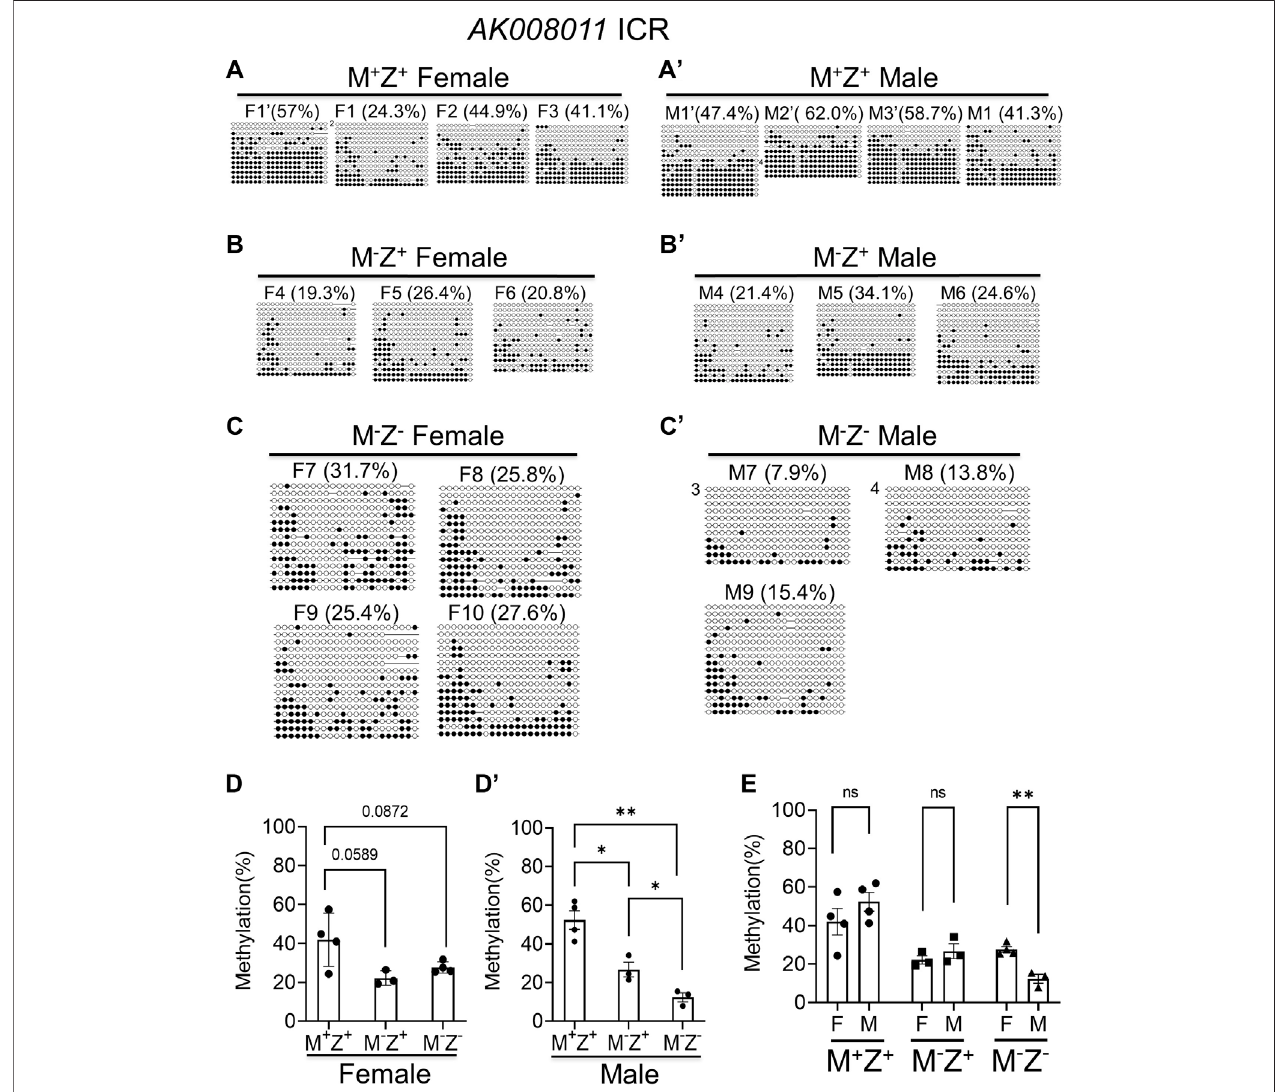
FIGURE 4 | DNA methylation at the AK008011 ICR was more signi fi cantly reduced in the male M - Z - embryos compared with the female ones based on bacterial colony bisul fi te sequencing analysis. Genomic DNA samples were isolated from at least three M + Z + , M − Z + , or M − Z - E13.5 embryos of each gender that had been used for RNA-seq analysesinthisstudytoo.Theyweresubjectedtobisul fi temutagenesisfollowedbybacterialcolonysequencingofthe605-bpbisul fi tePCRproductofthe AK008011 ICRregion. Theunconvertedcytosine (C) residueswereusedtodeterminetheuniqueclonesforthebisul fi tecolonysequencing.Eachrowrepresentsauniqueclone,withthe fi lledblack circlesformethylatedCpGsitesandun fi lledwhitecirclesforunmethylatedCpGsites.Thenumberinfrontofauniquecloneshowsthenumberofsequencednon-uniqueclones containing the same sequence that cannot be distinguished by unconverted (C) residues. The percentage of DNA methylation in (A,C ’ ) was calculated based on the number of methylated CpG sites divided by the total number of CpG sites for the sequenced unique clones of the bisul fi te PCR product. Two-tailed Student ’ s t test was used for statistical analysisofDNAmethylationleveldifferencesbetweentwodifferentgenotypesofthesamegender (D,D ’ ) orwithinthesamegenotypebetweenmalesandfemales (E) .Statistical signi fi cance:*, p < 0.05;**, p < 0.01; ns,notstatisticallysigni fi cant. (A ’ ) Four M + Z + femaleembryos(F1 ’ andF1 – F3). (A ’ ) Four M + Z + maleembryos(M1 ’– M3 ’ and M1). (B) Three M − Z + femaleembryos(F4 – F6). (B ’ ) ThreeM − Z + maleembryos(M4 – M6). (C) FourM − Z - femaleembryos(F7 – F10). (C ’ ) ThreeM − Z - maleembryos(M7 – M9). (D) DNAmethylationat the AK008011 ICRwassigni fi cantly reducedinfourM − Z - orthreeM − Z + femaleembryoscomparedwithfour M + Z + femaleembryos. (D ’ ) DNAmethylationatthe AK008011 ICR was signi fi cantly reduced in three M − Z - male embryos compared with four M + Z + or three M − Z + male embryos. It was also reduced in three M − Z + male embryos compared with four M + Z + maleembryos. (E) DNAmethylationatthe AK008011 ICRwassimilarcomparingM + Z + orM − Z + femaleembryoswiththeirmalecounterparts.Itwasmoresigni fi